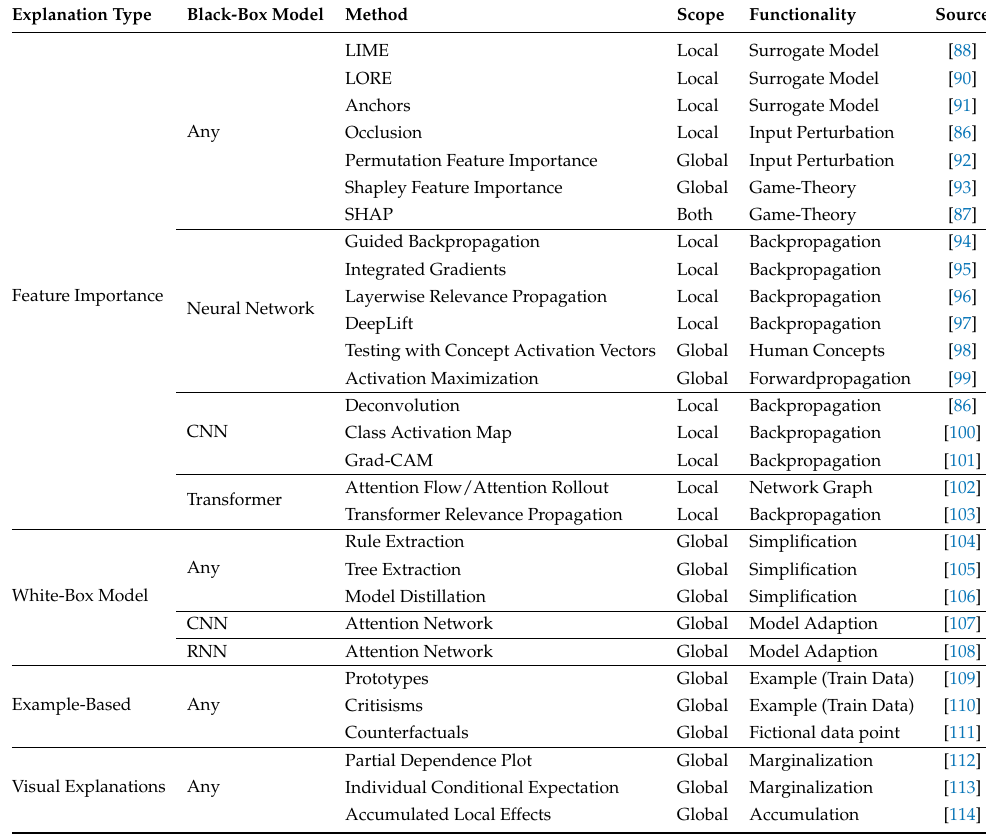
Table 1. Overview of the reported XAI